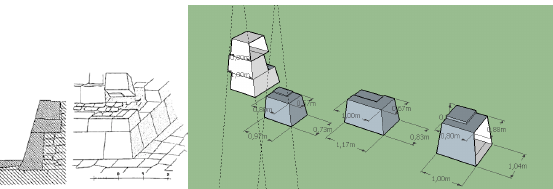
Figure 7: On the left an image, from Borchardt 1905 (fig. 26), showing the corner construction; on the right side, the single blocks (in grey) drawn from the 3D survey and their assemblage.